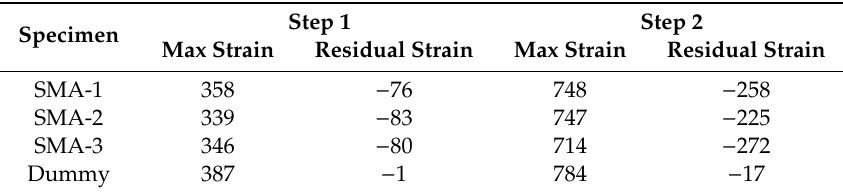
Table 6. Results of multi-step prestressing tests.